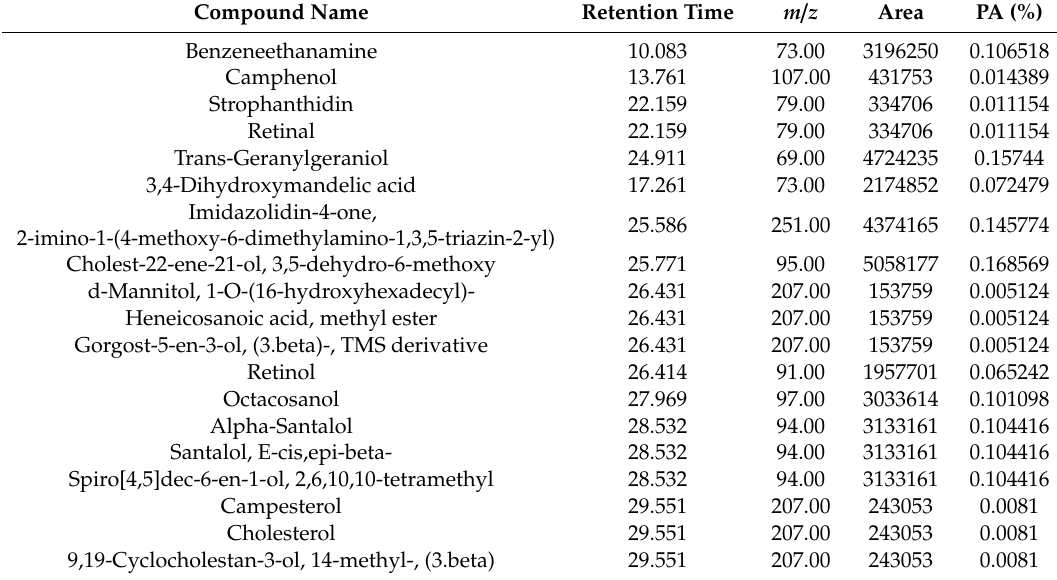
Table 1. Quantitative compounds identified from methanol extract of T. crispa by GC-MS analysis.